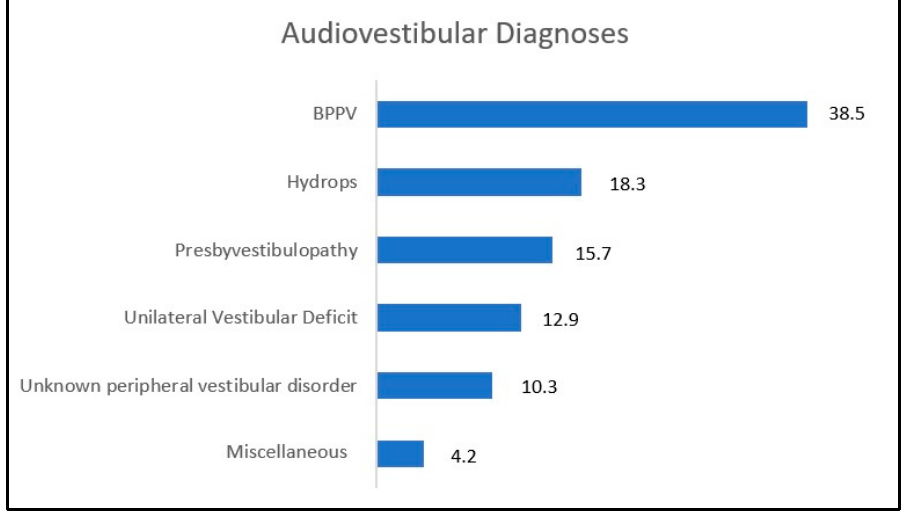
Figure 3. Audiovestibular diagnoses within the selected studies. All numbers are shown in